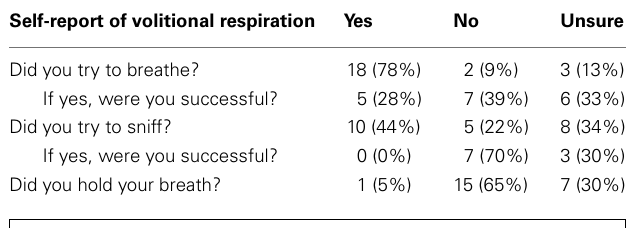
Table 3 | Self-report of volitional respiration ( N = 23).